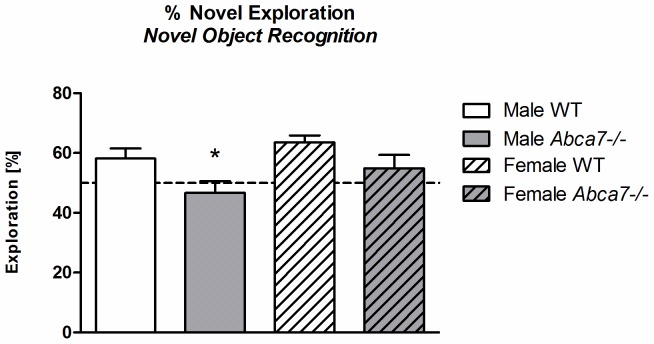
Novel object recognition.Percentage exploration [%] (i.e. duration of nosing and rearing) of the novel object (% novel exploration) is shown for males and females of both genotypes. Exploration of the novel object according to chance ( = 50%) is marked with a dotted line. Significant one-way ANOVA effects of Abca7
−/−
versus WT of the corresponding sex are indicated by ‘*’ (*p<.05).